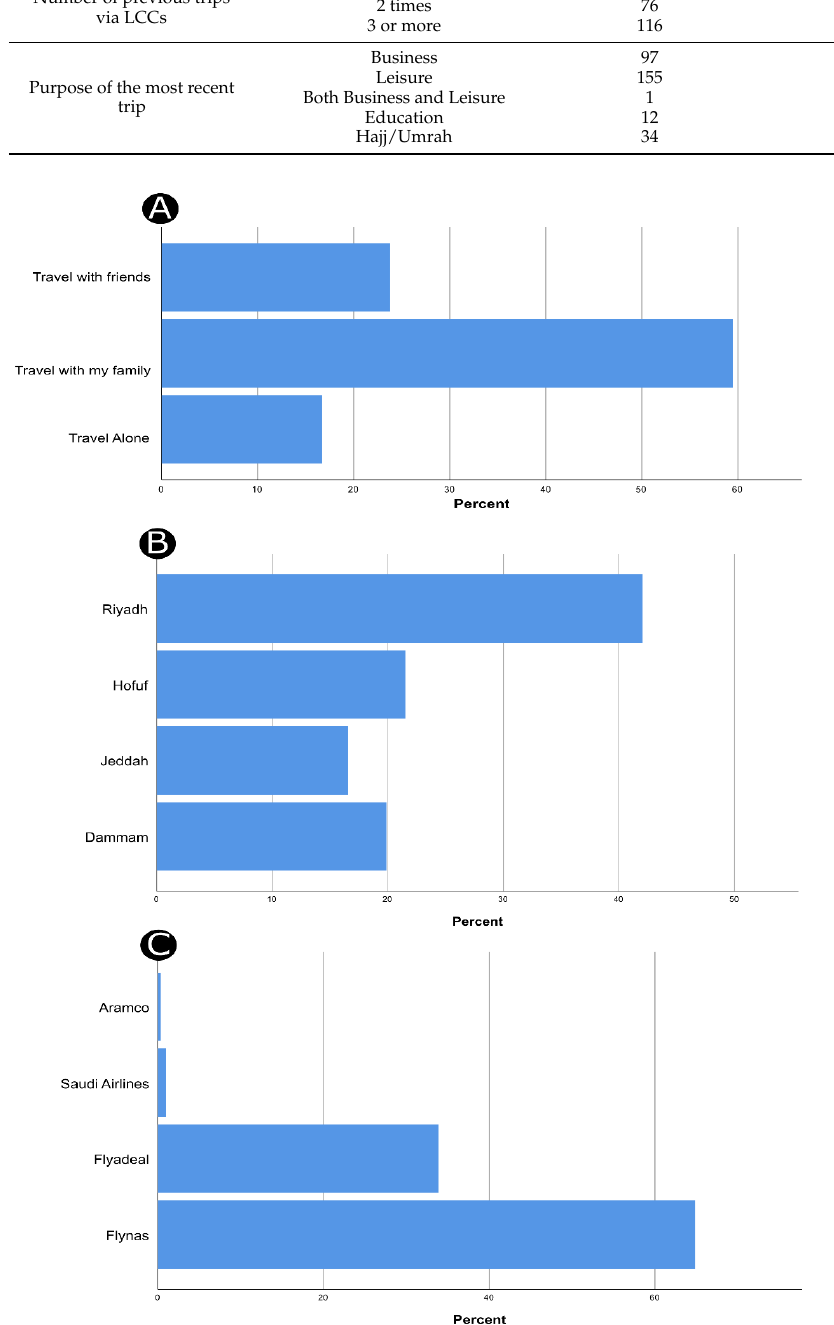
Figure 2. The results of the multiple response analysis regarding 311 responses about the partners during trips ( A ), 302 responses about the departure airport ( B ), and 313 responses about the used airlines ( C ).